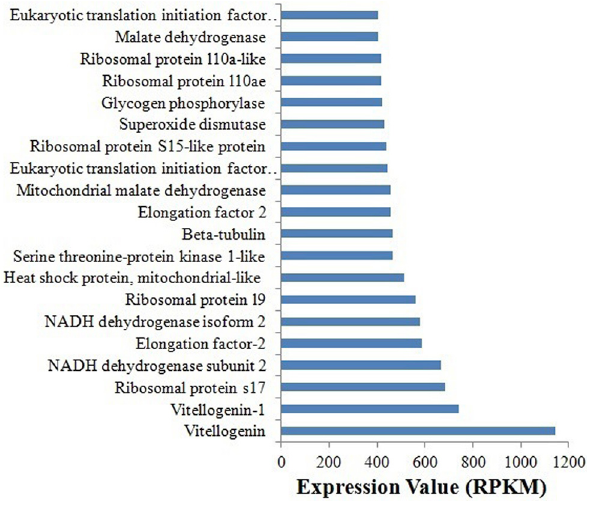
Fig 5. Gene expression analysis of transcriptome data. The figure shows top twenty high expressing genes in whitefly.